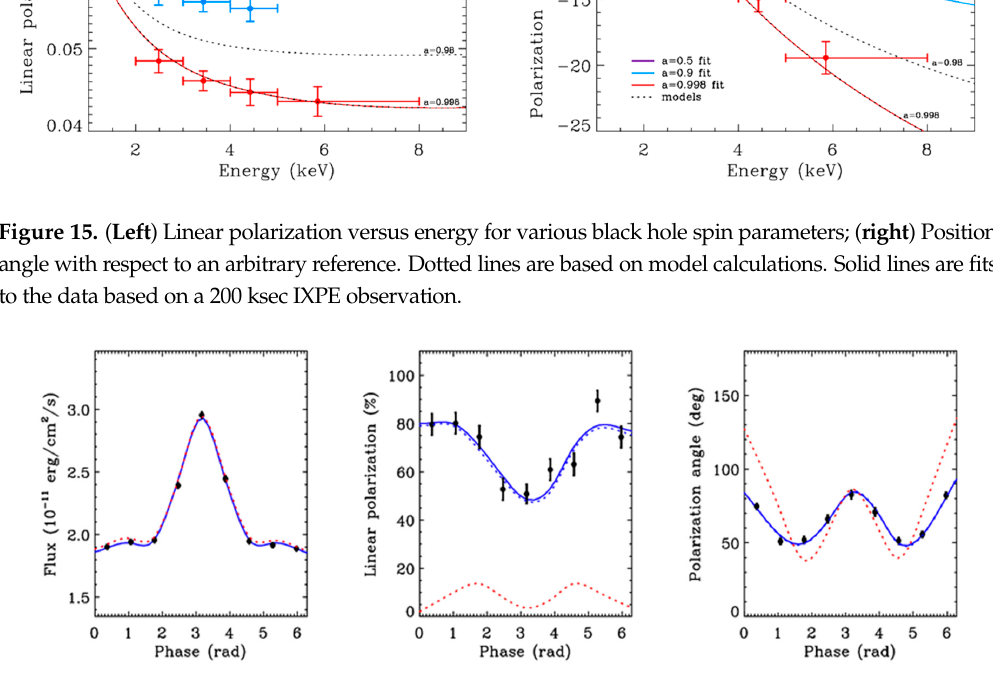
Figure 16. Left to right : flux, degree of polarization, and position angle, all versus the pulse phase for 1RXS J170849.0-400910. Blue and red curves represent QED accounted for and not accounted for, respectively. Data points and errors are for a 250-ksec observation.